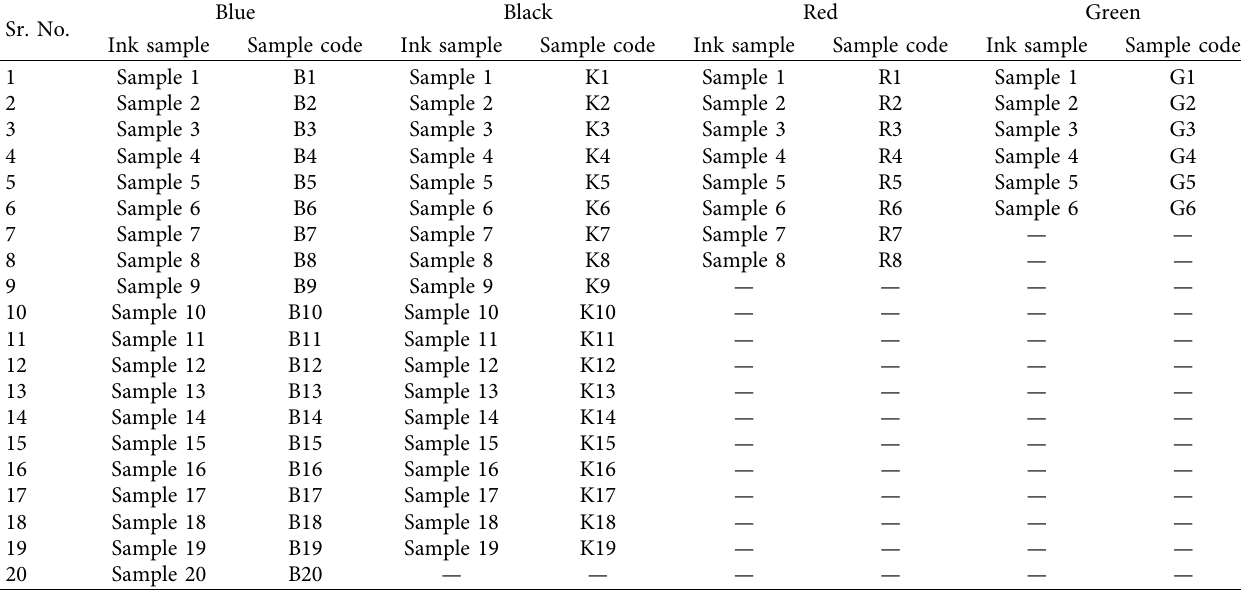
B: blue color; K: black color; R: red color; G: green